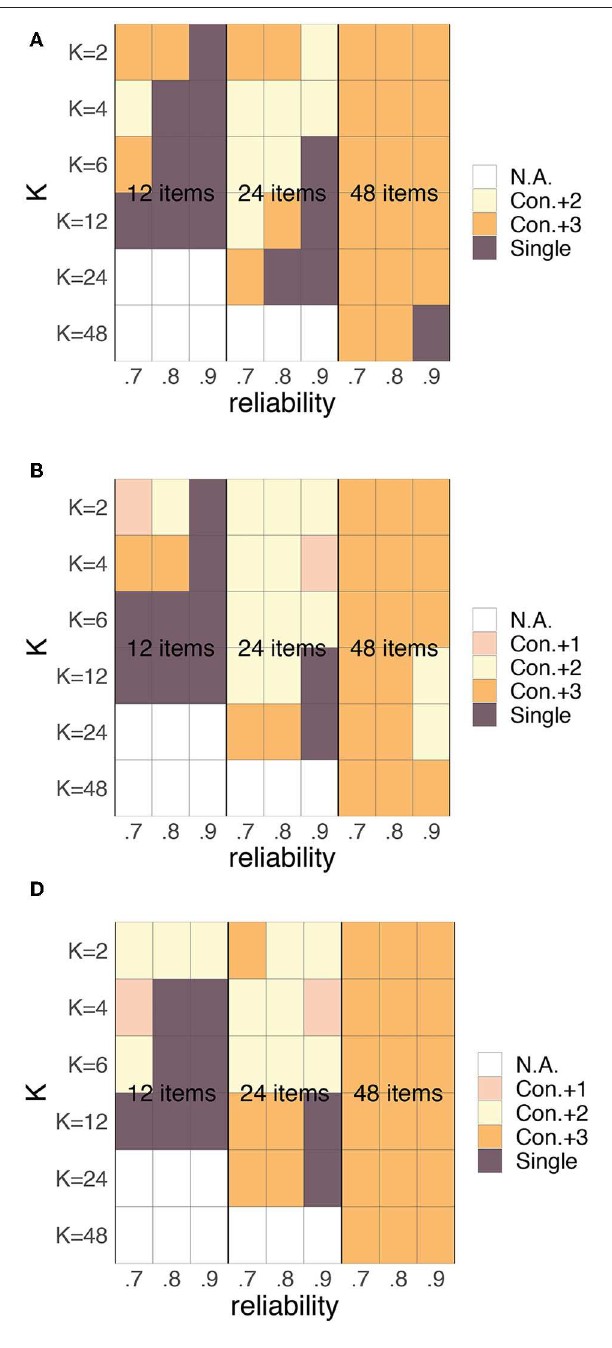
FIGURE 17 | Preference for the person-specific SEm (green), the conditional SEm (pink), the conditional SEm “ + 1” (light pink), the conditional SEm “ + 2” (yellow), the conditional SEm “ + 3” (orange) or the single SEm (purple) based on the MSE for different K ’s, number of items and overall reliability. Plot (A) corresponds to the relationship between “true” scores and error variances as depicted in Figure 5A, (B) to the relationship of Figure 5B, (C) to the relationship in Figure 5C and (D) to the relationship in Figure 5D. All four plots are based on rounded and truncated parallel test scores.